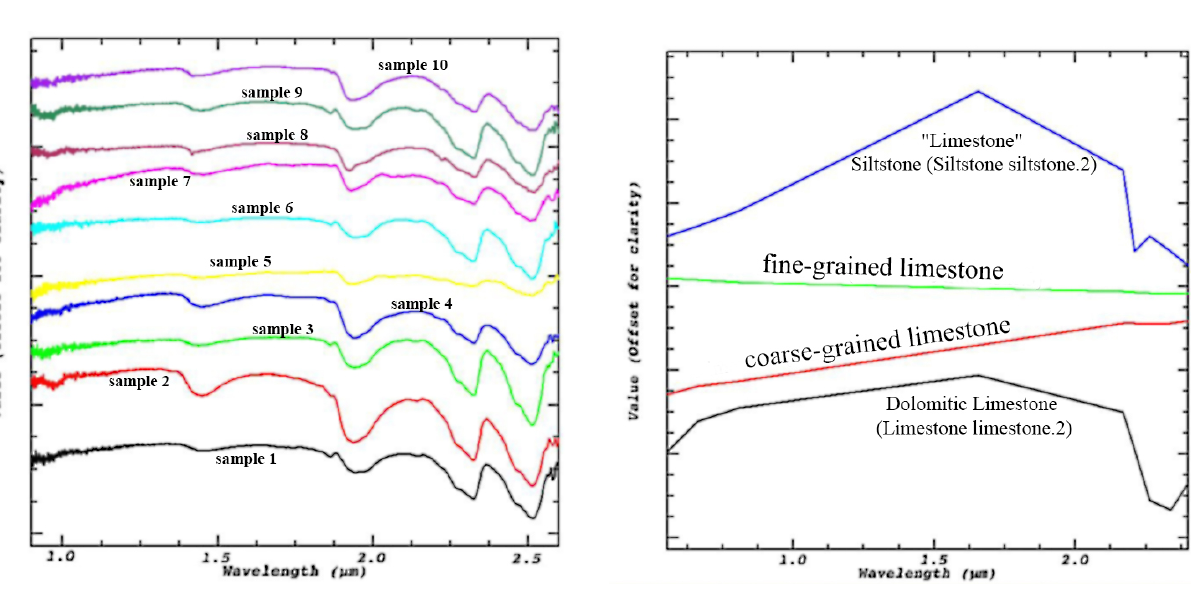
Figure 6. The spectra samples obtained by ASD instrument. Figure 7. Carbonate spectra of the JHU library, resampled to bands of ASTER sensor.